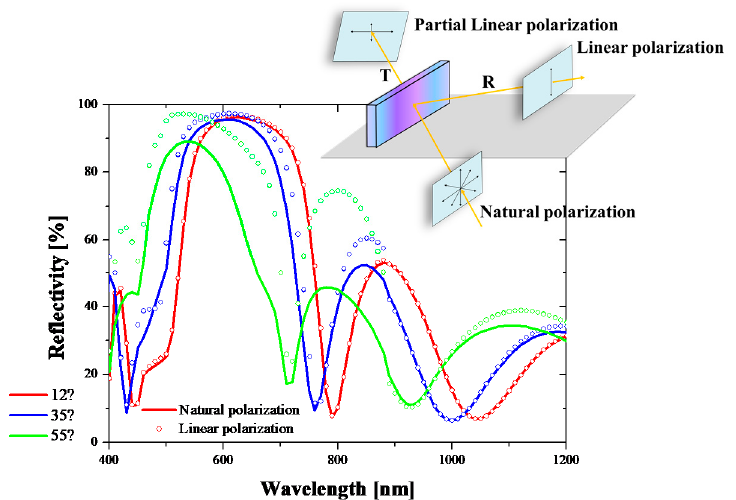
Figure 8. Incident angle dependency of PC1D as a function of the polarization of the incoming radiation. Solid lines correspond to natural polarization light, and open circles refer to linear polarization data.